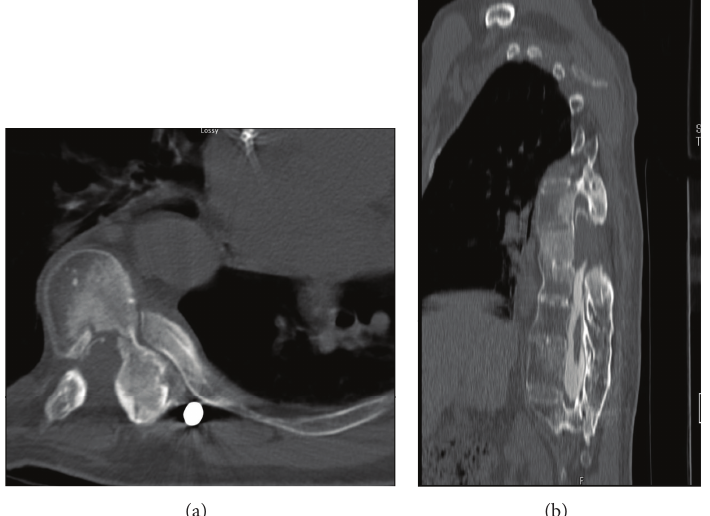
Figure 3: Axial and sagittal reformatted CT myelogram images over a year after the initial resection reveal tumor recurrence at the laminectomy segment with contrast block.